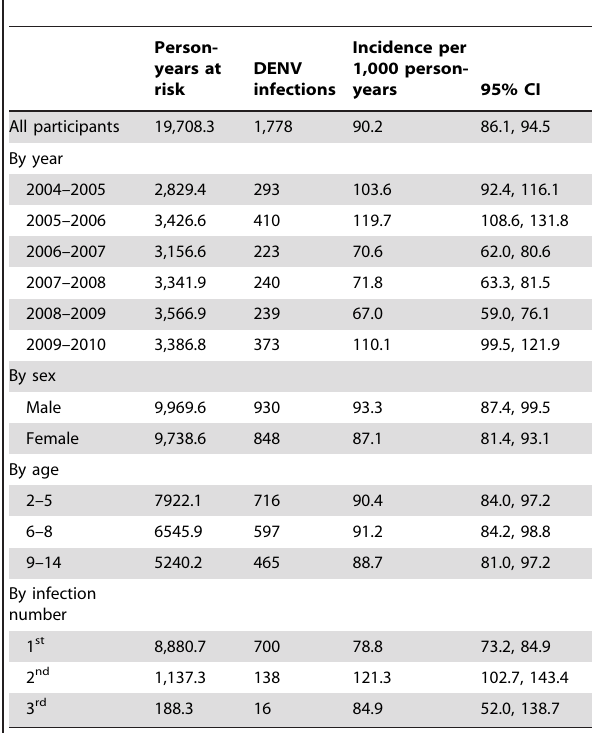
Table 3. Incidence of DENV infections, Managua,